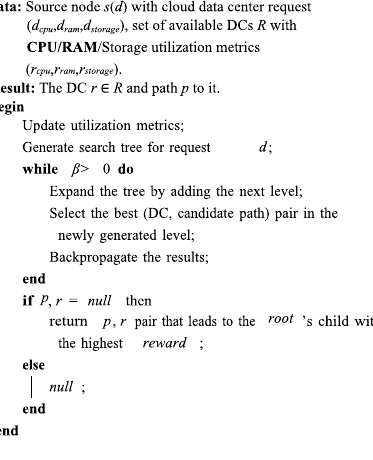
Algorithm 1: Monte Carlo Tree Search